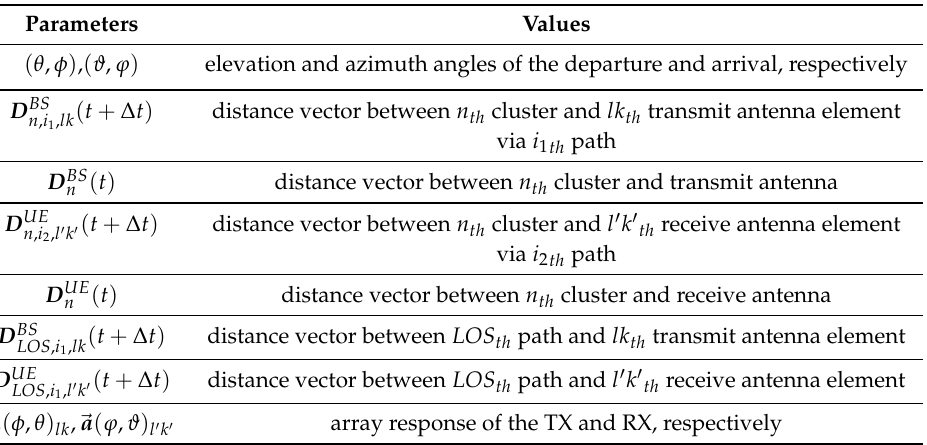
Table 2. Summary of key parameter